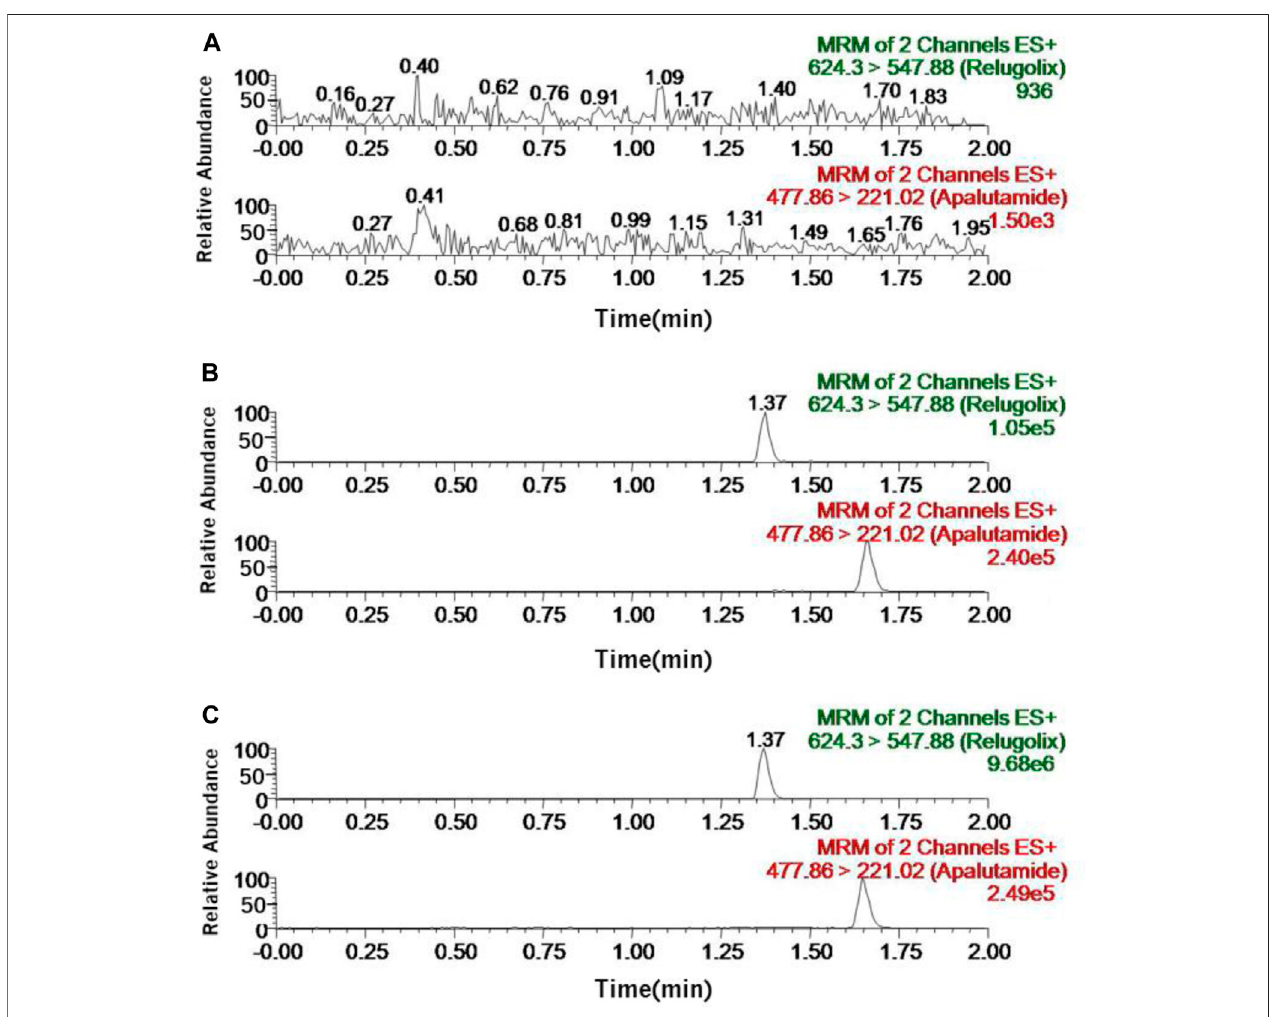
FIGURE 2 | Representative chromatograms of relugolix and IS in rat plasma samples: (A) the blank plasma sample; (B) the blank plasma sample with relugolix at the LLOQ concentration (0.7 ng/mL) and IS; (C) the rat plasma sample after oral administration of 12 mg/kg relugolix.